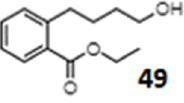
Figure 8. Chemical structures of a rare complex oxylipin momordicatin, 4-(o-carboethoxyphenyl) butanol ( 49 ).